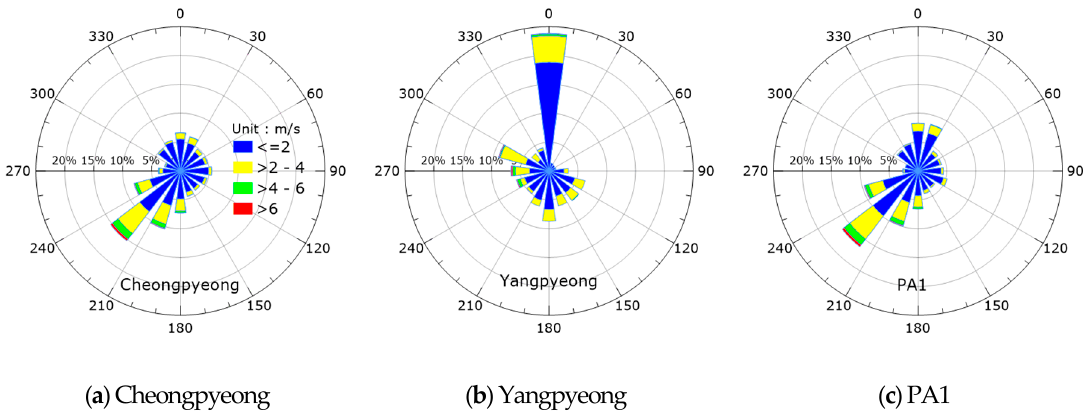
Figure 9. Wind roses by meteorological station from 9 May to 17 June 2016.